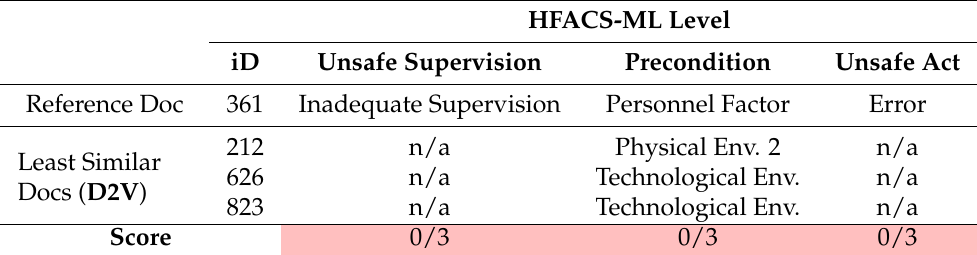
Table 4. Least similar documents, from the D2V DM